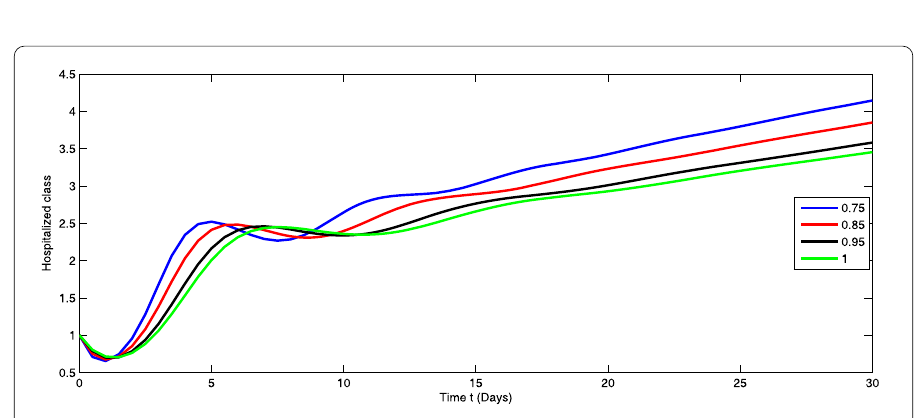
Figure 4 Graphical representation of the approximate solution H for the first ten terms at different fractional